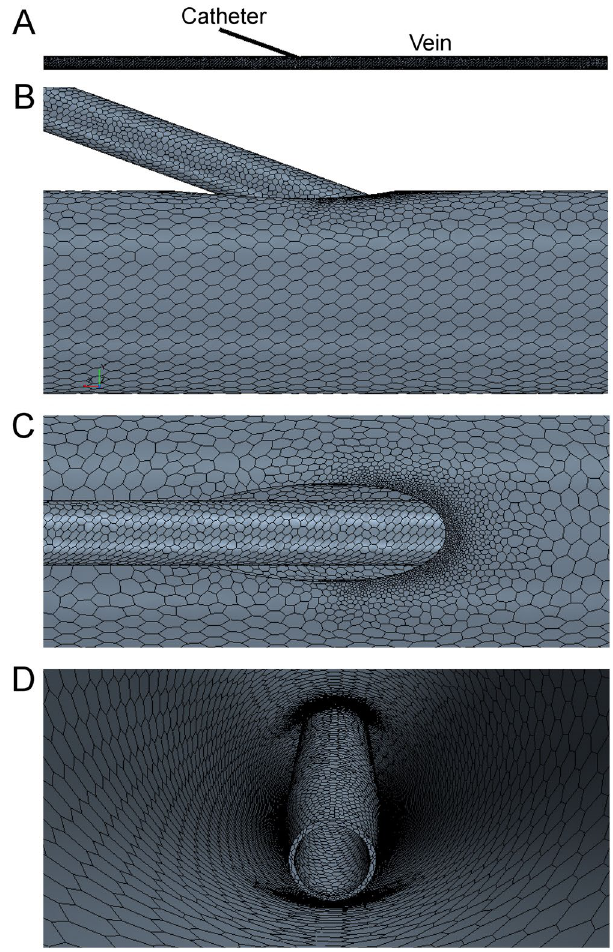
Figure 8. Representative computational mesh on the 20 G, 20° insertion angle, positioned at the vessel edge. ( A ) Entire domain showing catheter inserted into vein. Close-up of mesh showing refinement around insertion region from the side ( B ), top ( C ) and internal ( D ) views. Element size was reduced inside the catheter and in catheter-vein